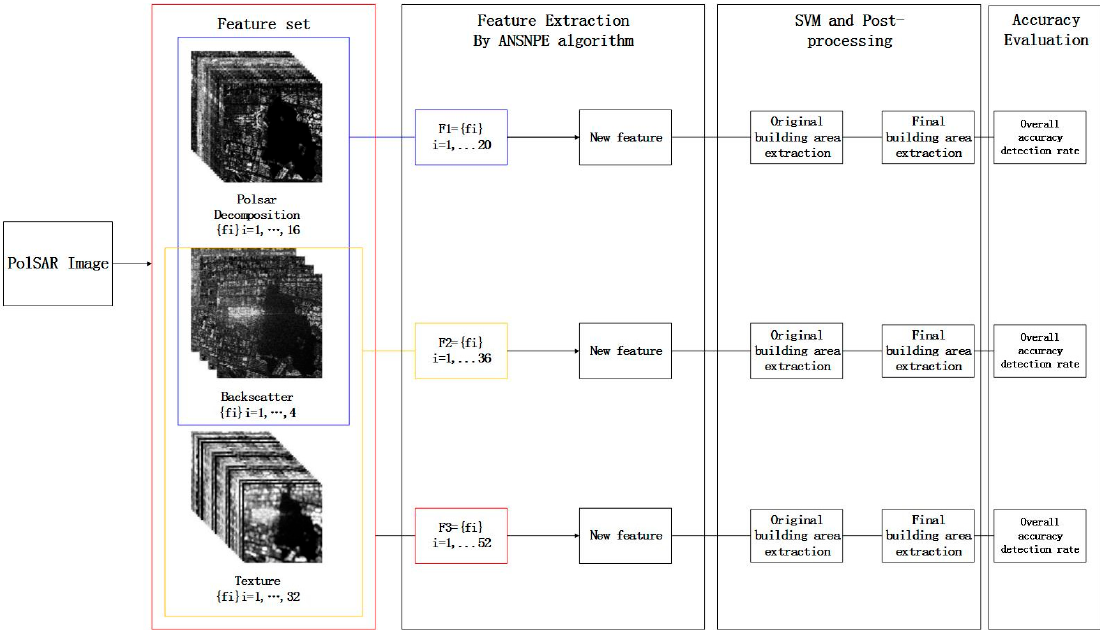
Figure 2. The Extraction Framework.